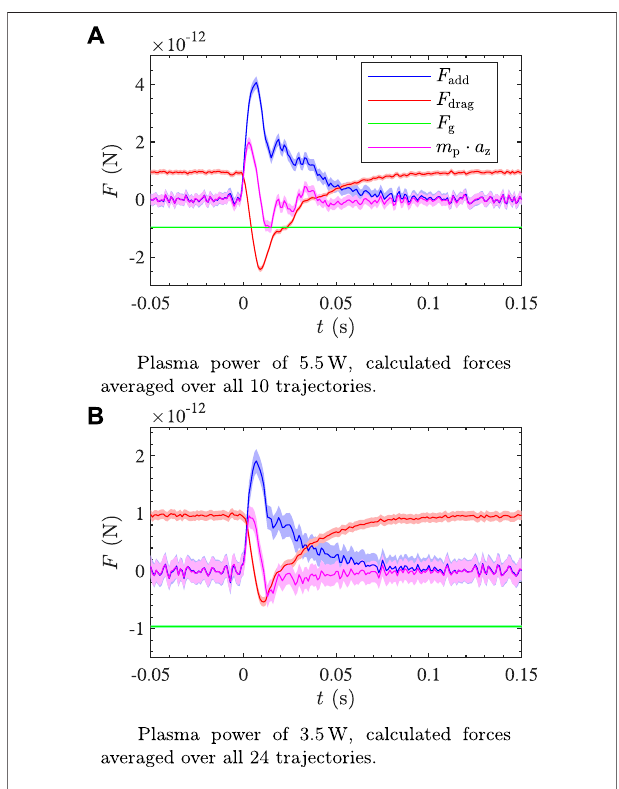
FIGURE 3 | Calculated force balance for experiments with a plasma power of (A) 5.5 W and (B) 3.5 W, averaged over all (10 and 24 respectively) trajectories in each